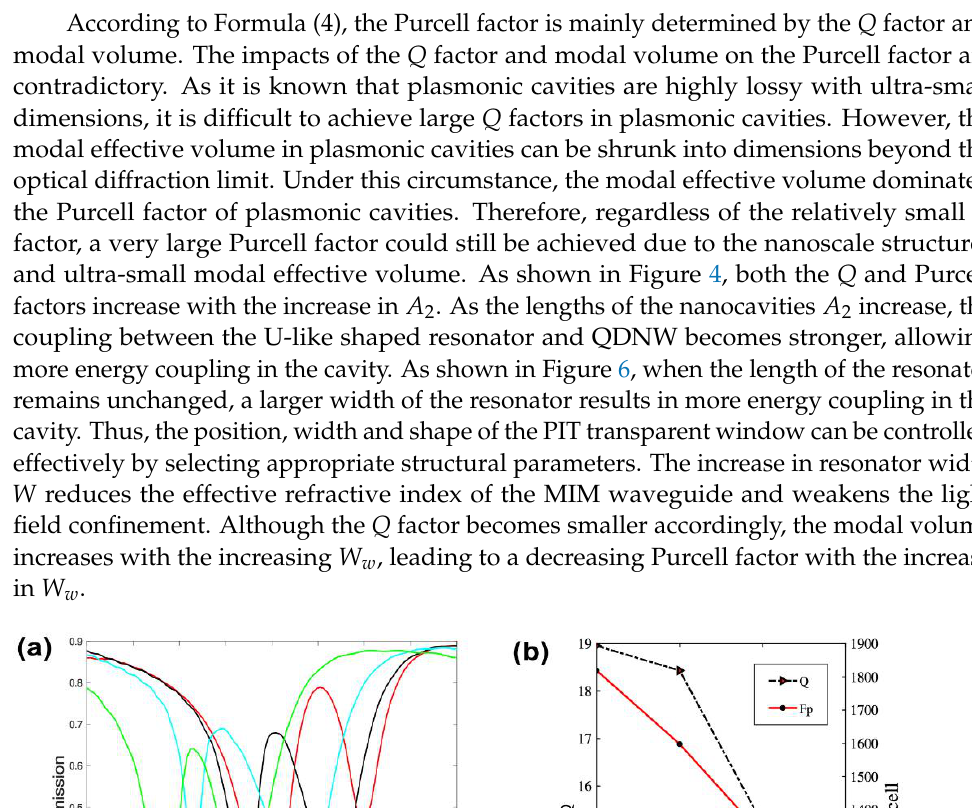
Figure 5. The transmission spectrum ( a ) and Q /Purcell factors ( b ) corresponding to varying L w .